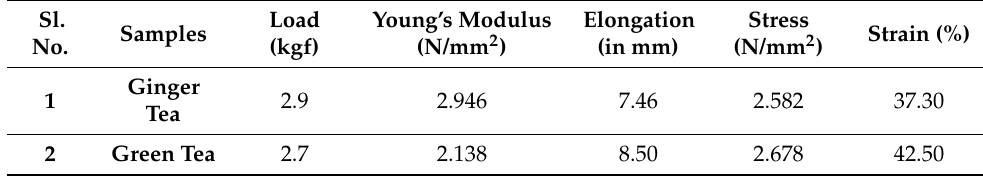
Figure 2. Mechanical properties of the prepared bioplastic samples ( a ) load, ( b ) elongation and ( c ) stress vs. strain curve. Table 2. Tensile properties of different samples.